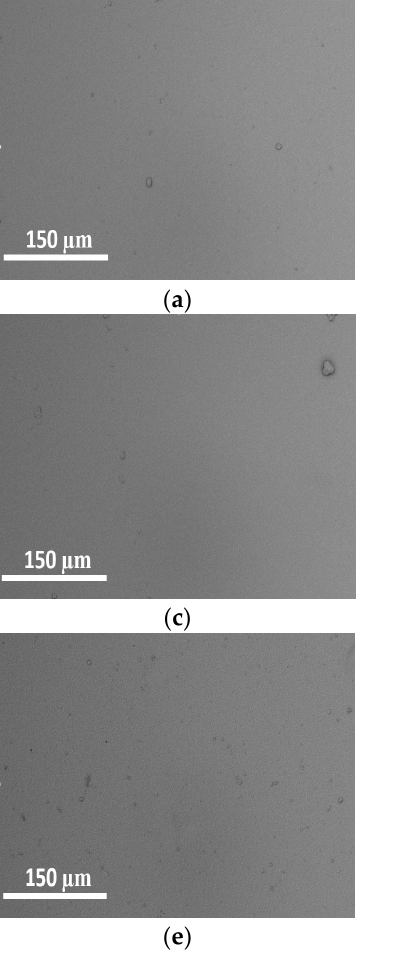
Figure 5. SEM images of the surface of the selective membrane layer before: ( a ) PDecMS; ( c ) PHeptMS; ( e ) MDK-3 and after one month of contact with ABE-fermentation broth: ( b ) PDecMS; ( d ) PHeptMS; ( f ) MDK-3.